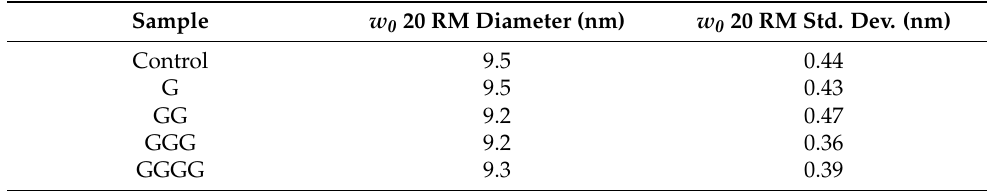
Table 1. Dynamic light scattering (DLS) size measurements of RM containing each of the G peptides. Each of these measurements was taken at pH